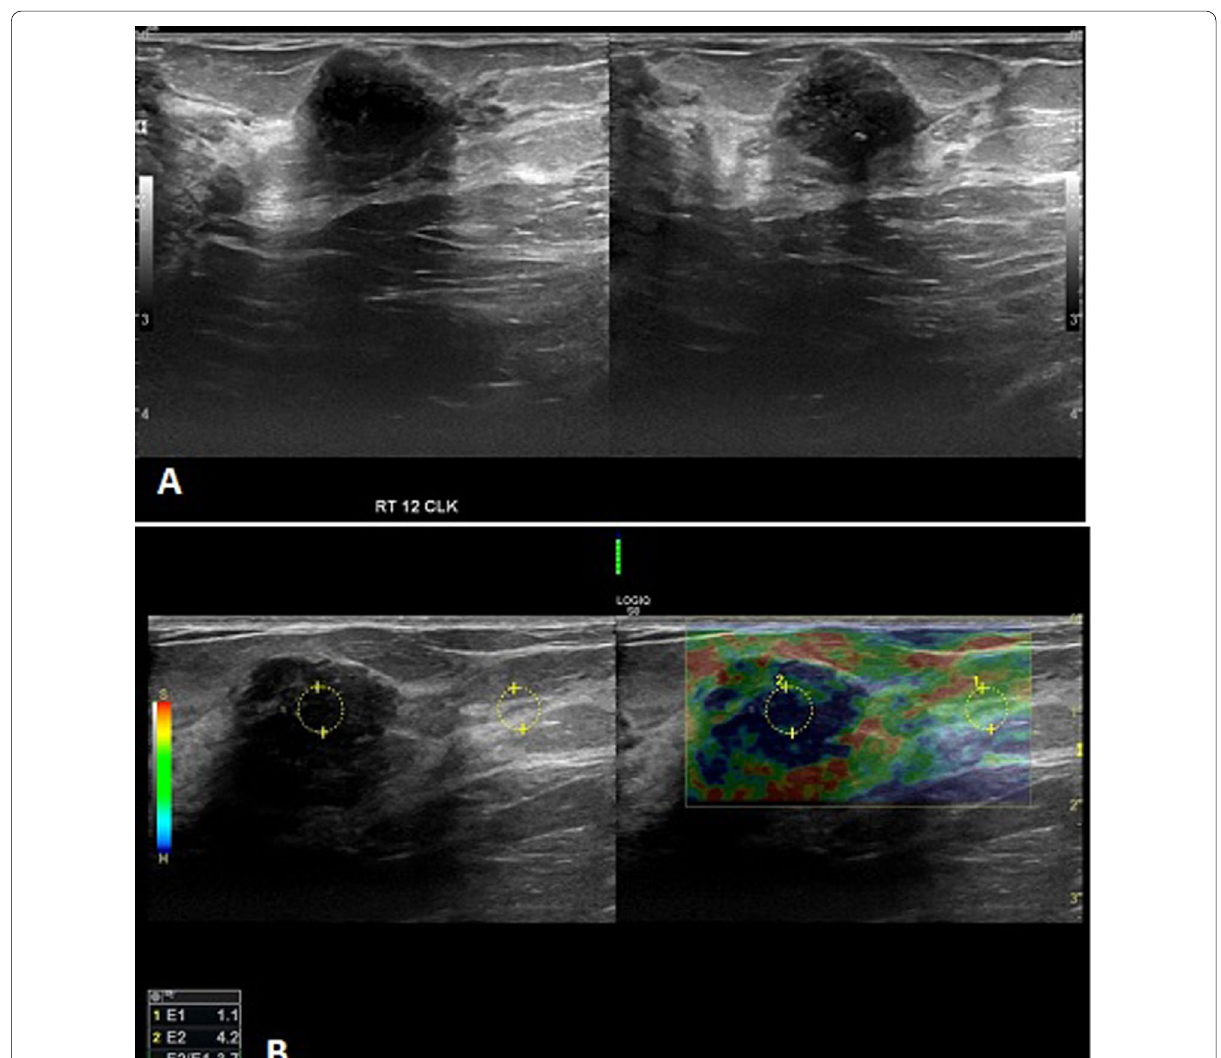
Fig. 3 Ultrasound of same lesion as described in mammogram in right breast 12 o’clock position showing a a rounded hypoechoic lesion with micro-lobulations and angular margins having posterior acoustic shadowing, b strain elastography was also performed with ratio of 3.7 which indicated hard